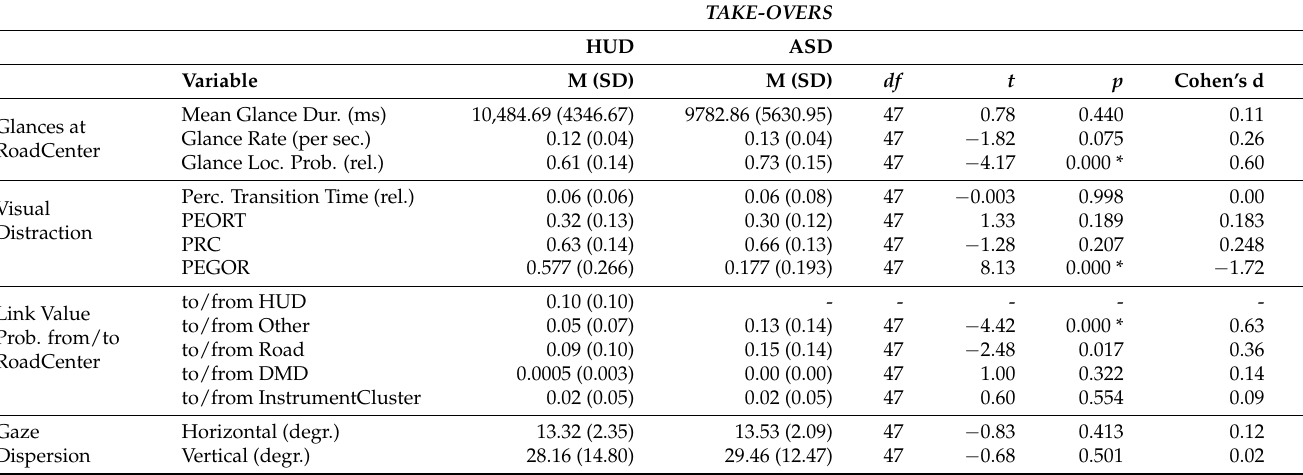
Table 2. Descriptive statistics of visual behavior measures during the take-overs (TOR, manual driving, handback) in the conditions heads-up display (HUD) and auditory speech display (ASD). We report the mean (M) and standard deviation (SD), t -test statistics, and effect sizes (Cohen’s